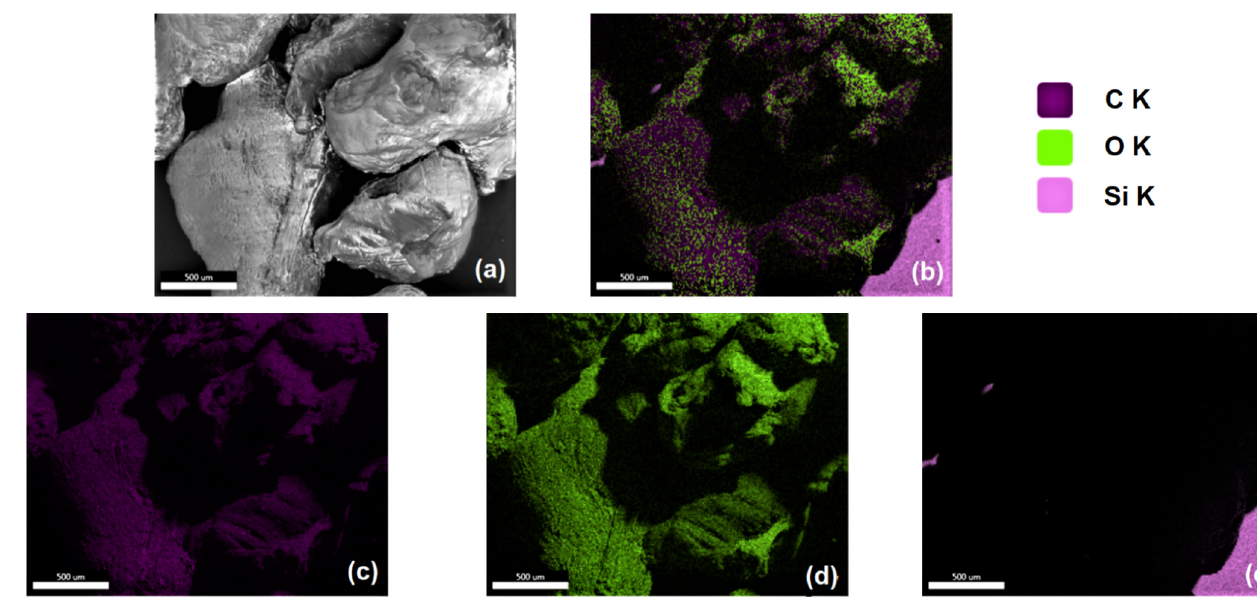
Figure 4. SEM-EDS images of PLA: ( a )—SEM image of PLA and X-ray maps of ( b )—carbon, oxygen, silicon; ( c ) carbon; ( d )—oxygen; ( e )—silicon.